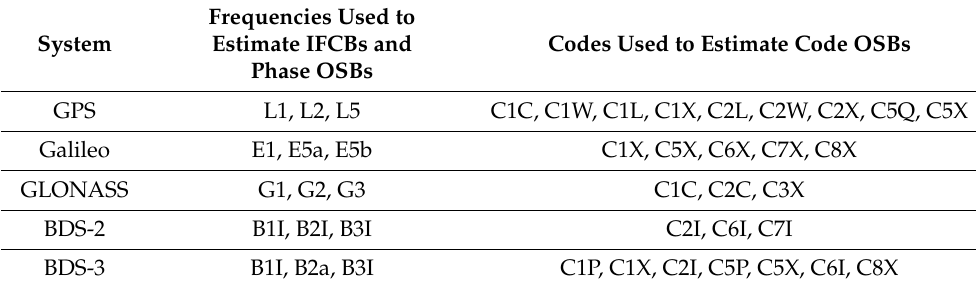
Table 2. The selected frequencies and codes in the